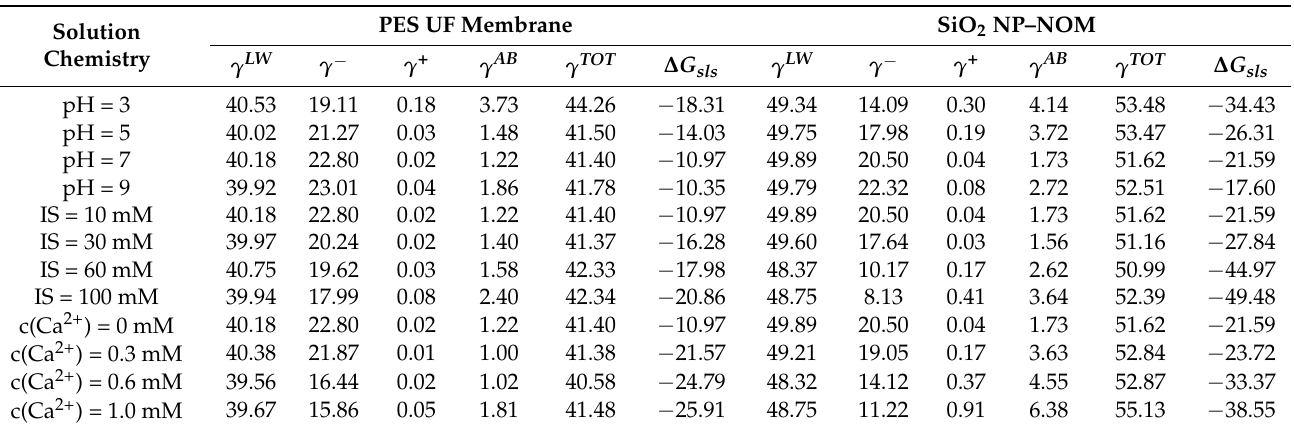
Table 2. Surface tension parameters (mJ/m 2 ) and free energy of cohesion (mJ/m 2 ) of UF membrane and SiO 2 NP–NOM mixture under different solution